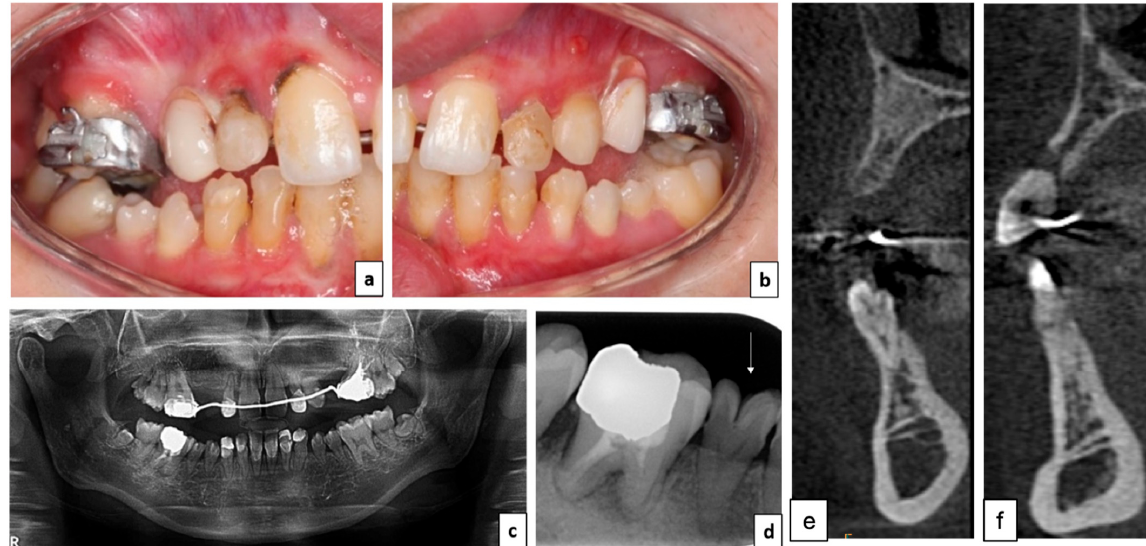
Figure 2. Clinical situation 10 years later (early adulthood). ( a , b ) Intraoral lateral views; ( c ) panoramic X-ray of the situation; ( d ) retro-alveolar X-ray of tooth number 45 showing atypical corono-radicular morphology; ( e ) CBCT-scan of the right maxilla canine region; and ( f ) CBCT-scan of the left premolar region.